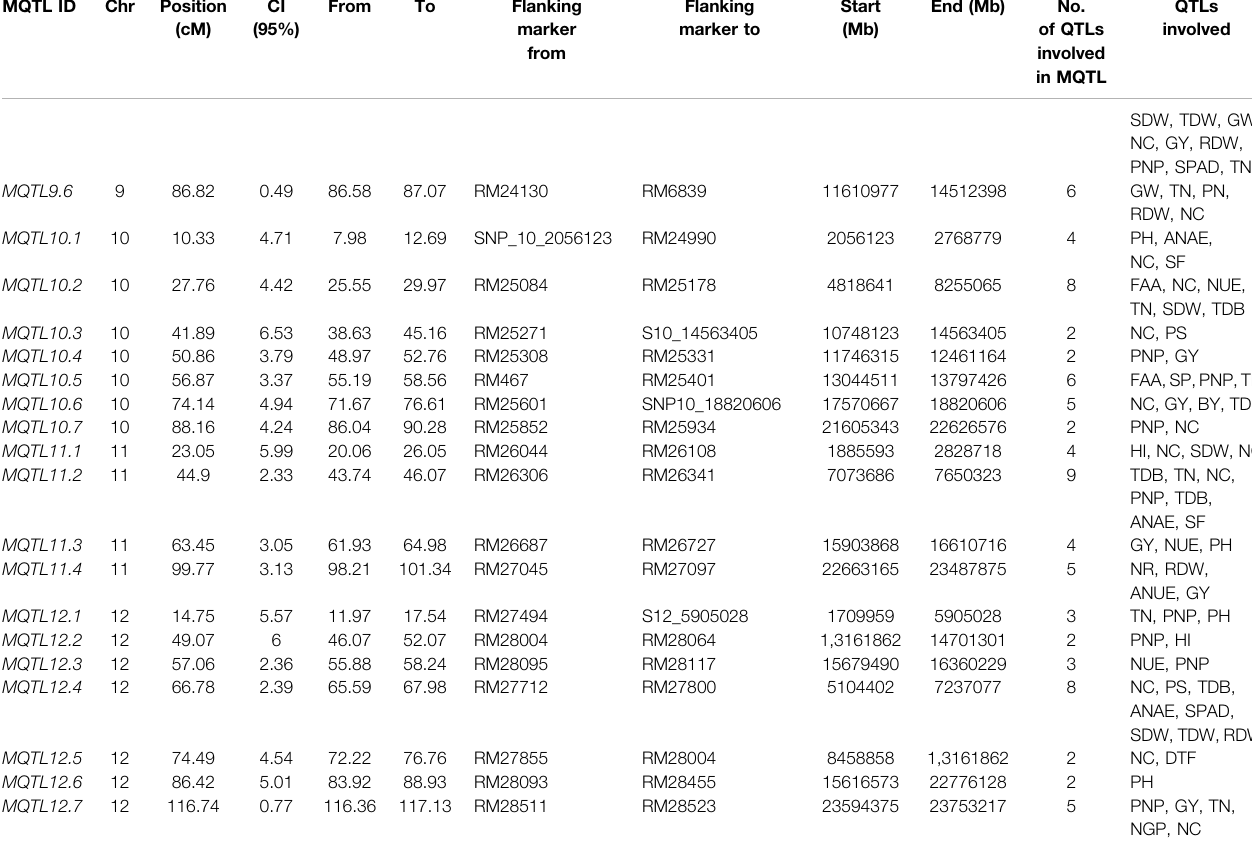
Figure 2A . The average con fi dence interval of the